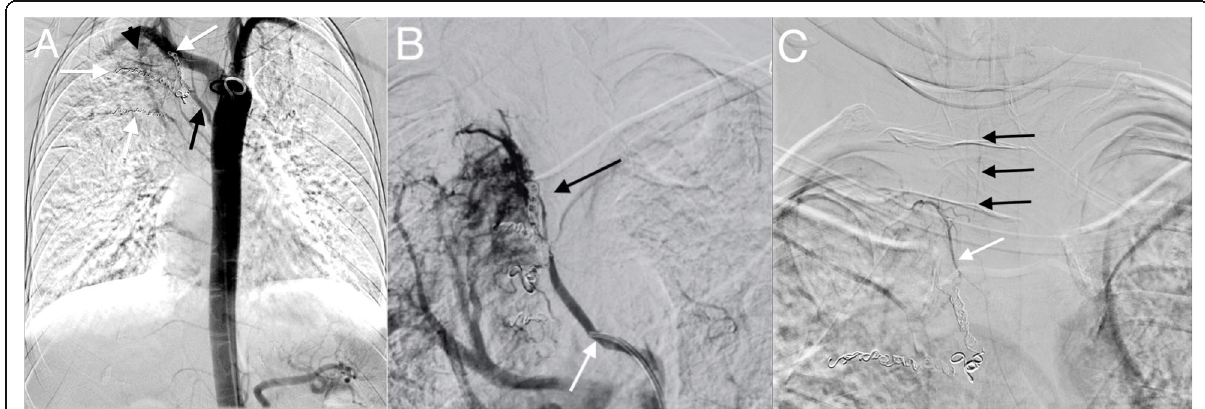
Fig. 1 a Thoracic AP digital subtraction aortogram shows a dominant right intercostal bronchial trunk (black arrow) and additional hypertrophied right intercostal arteries, all of which had been previously embolized with coils (white arrows). Tortuous ectatic vessels are also present arising from the upper thoracic segmental arteries (black arrowhead). b Magnified right anterior oblique (RAO) superselective angiogram with microcatheter in the right fourth intercostal artery (white arrow) demonstrates multiple recanalized coils (black arrow). c Slight RAO superselective angiogram of a branch of the prominent intercostal bronchial trunk (white arrow) showed a spinal artery branch (black arrows). This bronchial artery was not embolized